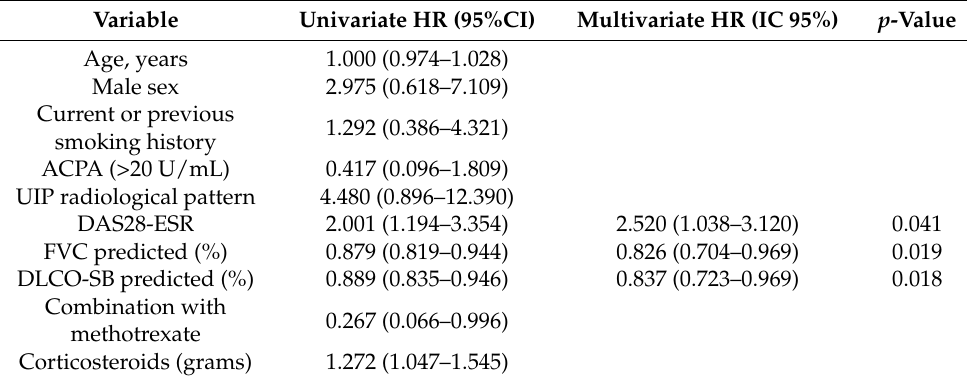
Table 4. Multivariate analysis of factors associated with progression of lung disease and mortality in patients with RA-ILD at initiation of treatment with abatacept. Cox regression model (adjusted for time receiving